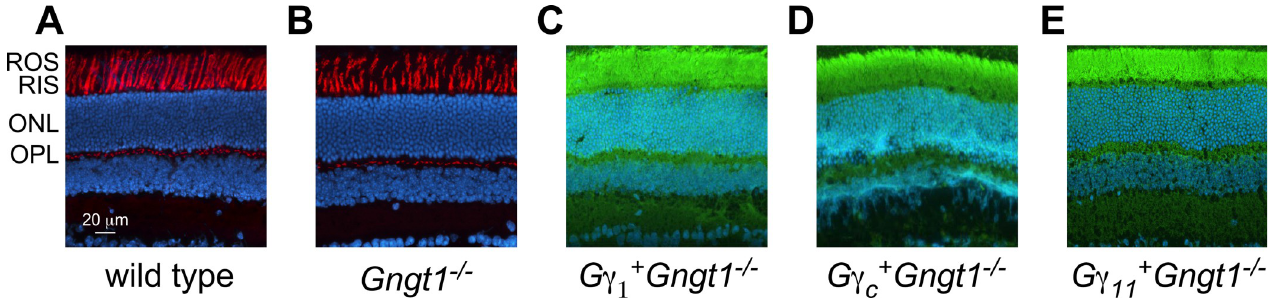
Fig 3. Immunohistochemical analysis of the transgenic protein expression using anti-FLAG antibodies (green), with DAPI counterstaining (blue), at P30. ( A ) and ( B ) are also counterstained with wheat germ agglutinin (red) to highlight ROS/RIS. Cryo-sections, 40x. ( A ) wild type, ( B ) Gngt1 -/- , ( C ) G γ 1+ Gngt1 -/- , ( D ) G γ c+ Gngt1 -/- , ( E ) G γ 11+ Gngt1 -/- retinas. ROS–rod outer segments, RIS–rod inner segments, ONL–outer nuclear layer, OPL–outer plexiform